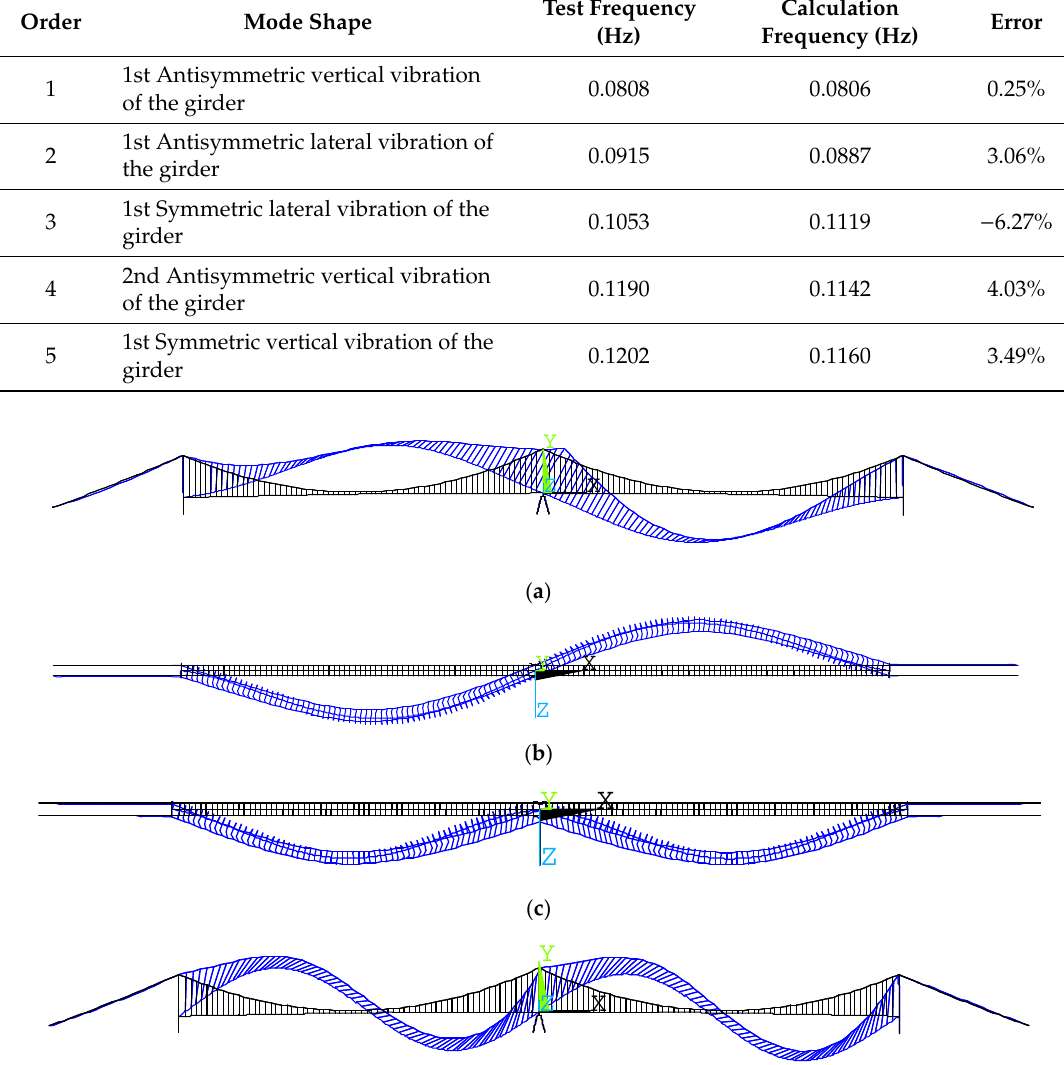
Table 3. Comparison results of vibration frequency.